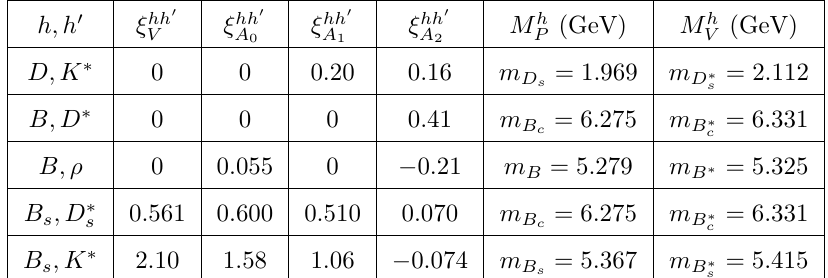
Table 14 . Second part of the table with parameters of meson form factors (C.28){(C.30) of decay into vector meson [112{114]. Masses of B c , D s and D (cid:3) prediction [115] is